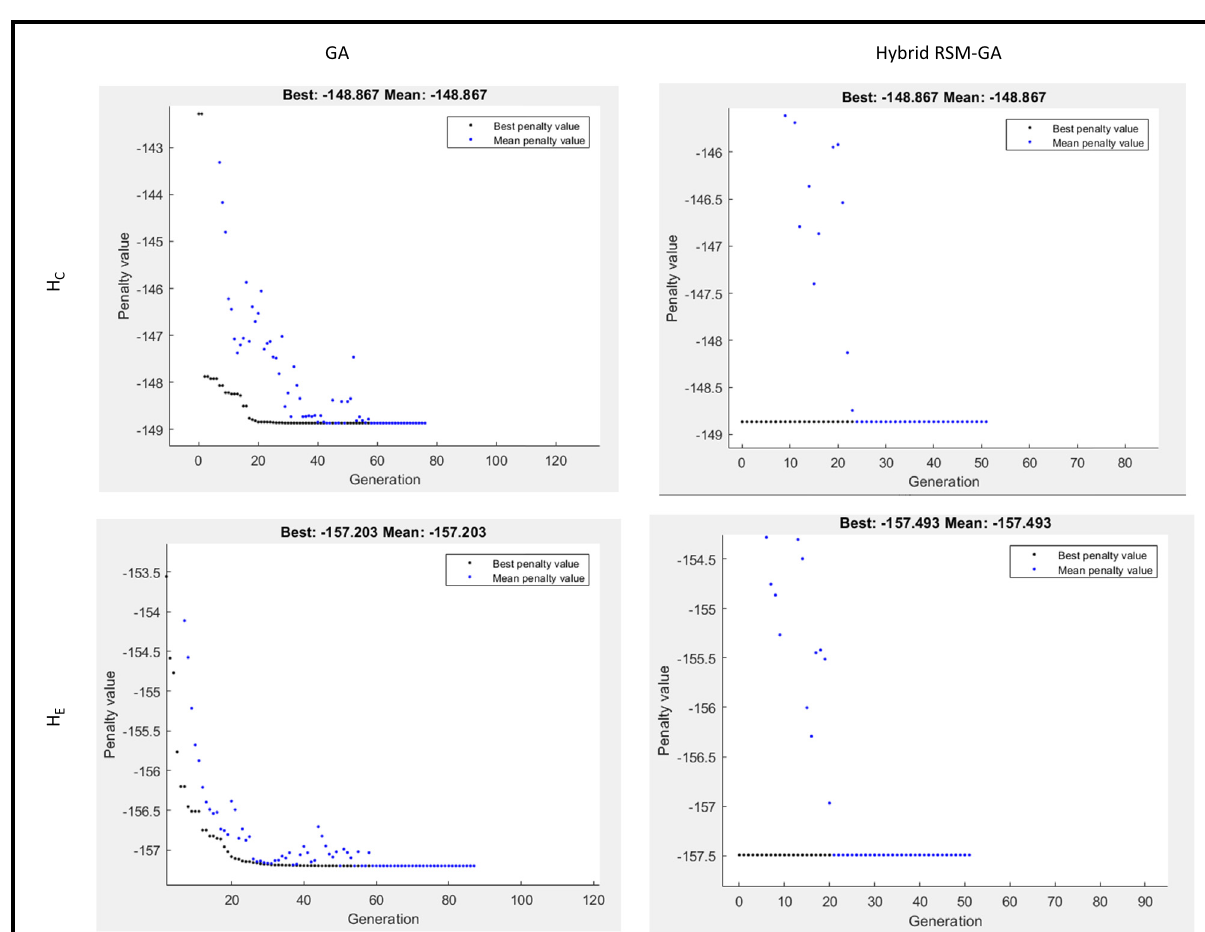
Figure 24: Optimum H C and H E by GA and hybrid RSM –